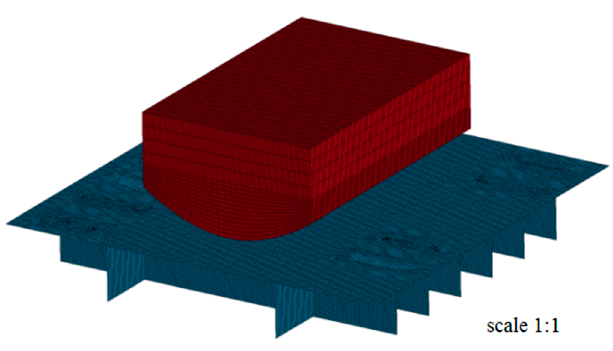
Figure 17. Finite element model of the drop test.